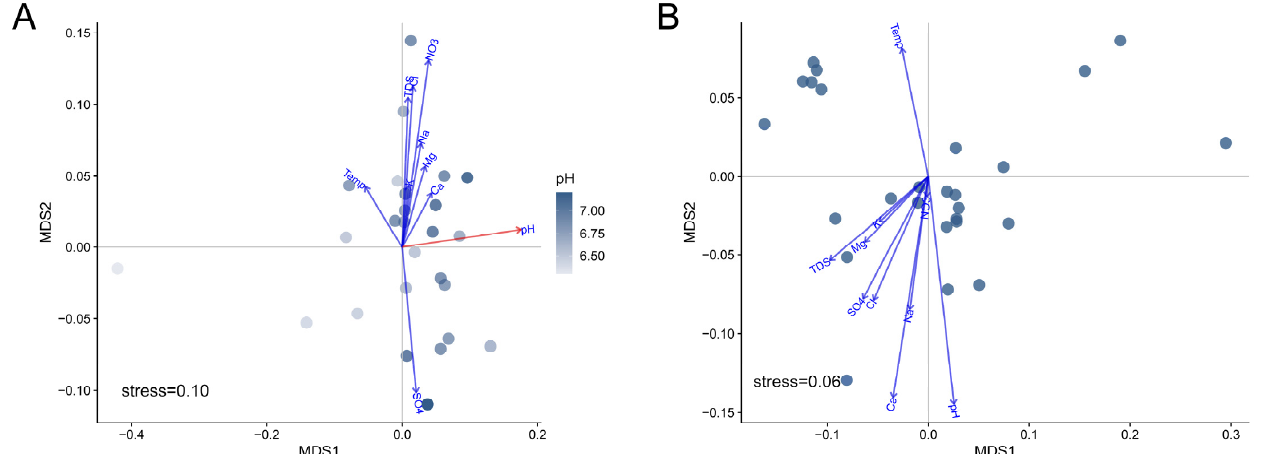
Figure 4. Non-metric multidimensional scaling (NMDS) ordination based on the weighted UniFrac distances of bacterial communities ( A ) and archaeal communities ( B ).